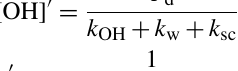
Figure 6. Correlation between the measured OH interference, de- termined by chemical modulation, and the NO 3 concentration mea- sured during an experiment when NO 3 (from thermal decomposi- tion of frozen N 2 O 5 crystals) was present in the chamber. Measure- ments were fitted to a linear function forced through the